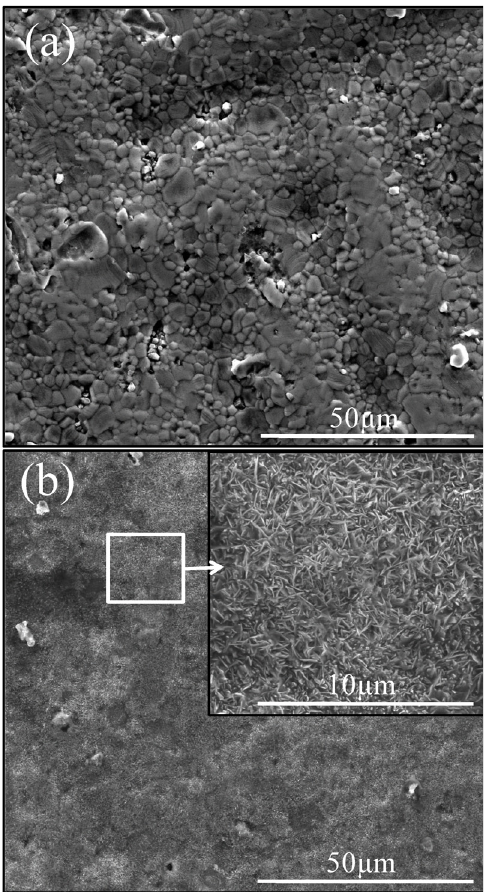
Figure 1. Scanning electron micrographs of the surface morphology of the specimen. (a) After pack cementation, and (b) after oxidation.